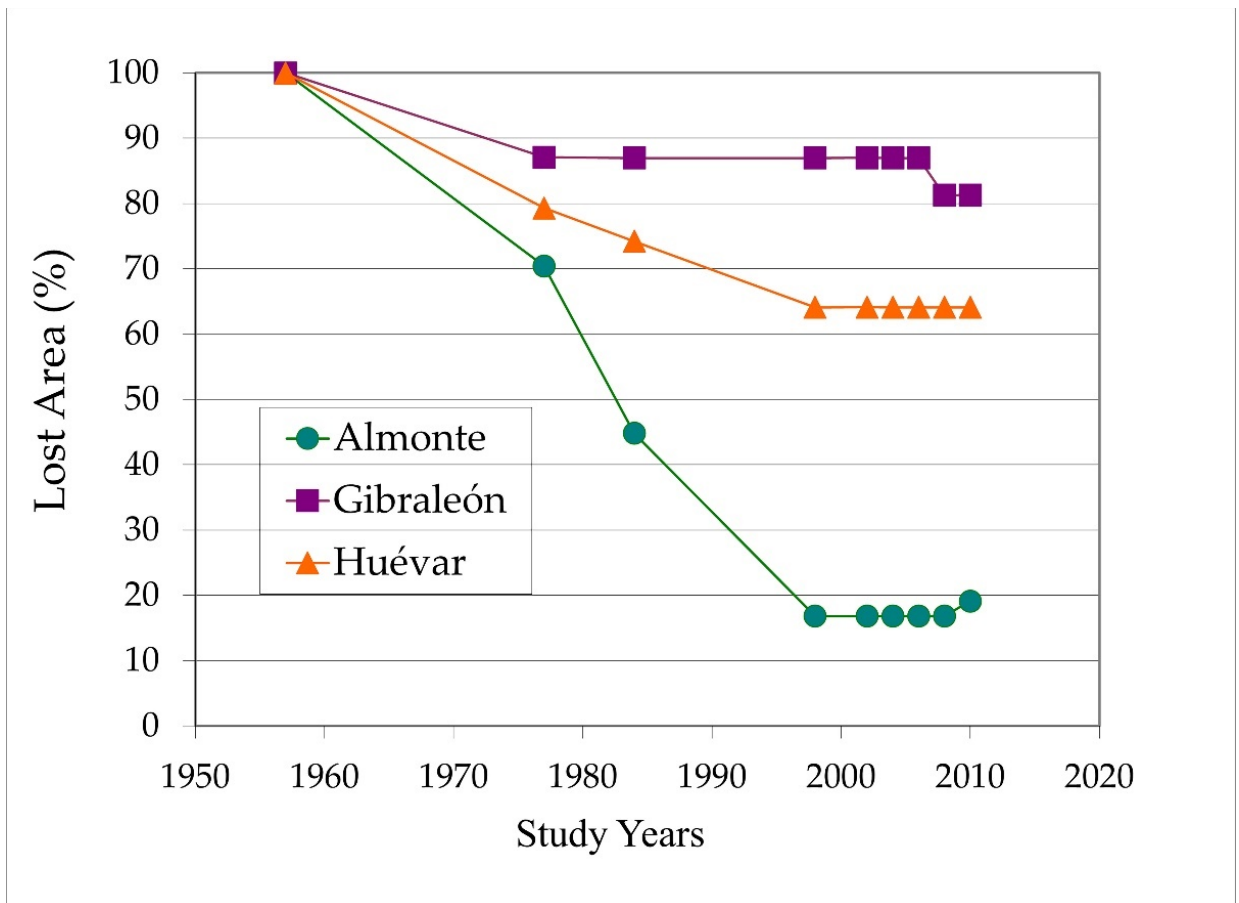
Figure 2. Lost dehesa surface percentage of each study patch throughout of the analyzed period (1957–2010).